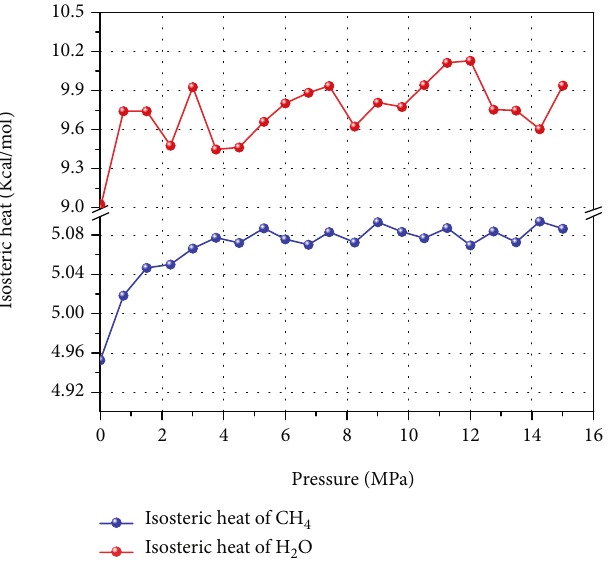
Figure 6: Isothermal adsorption heat curves of single-component at 303.15K. Table 6: Two-component isothermal adsorption data of the long- fl ame coal molecule to CH